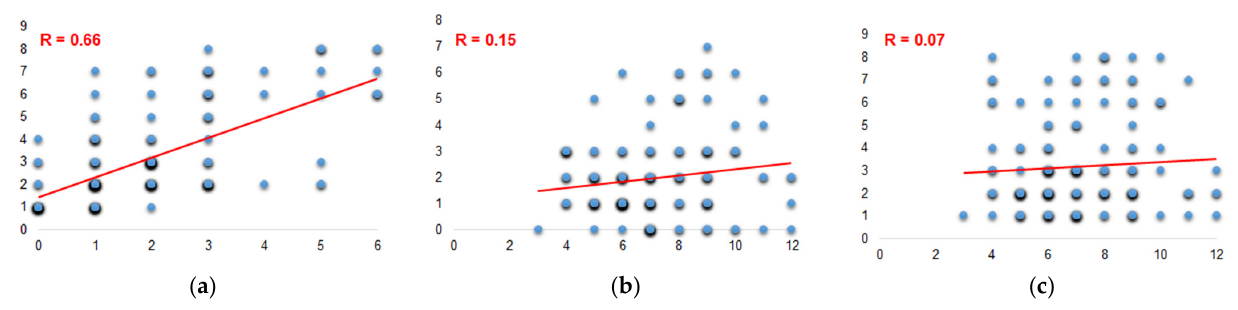
Figure 2. Scatter plots showing linear regression lines and correlation coefficients between the levels of phenotypic and genotypic resistance ( a ), the number of ERIC-PCR bands and phenotypic re- sistance ( b ), the number of ERIC-PCR bands and ARGs detected in Enterococcus isolates ( c ).